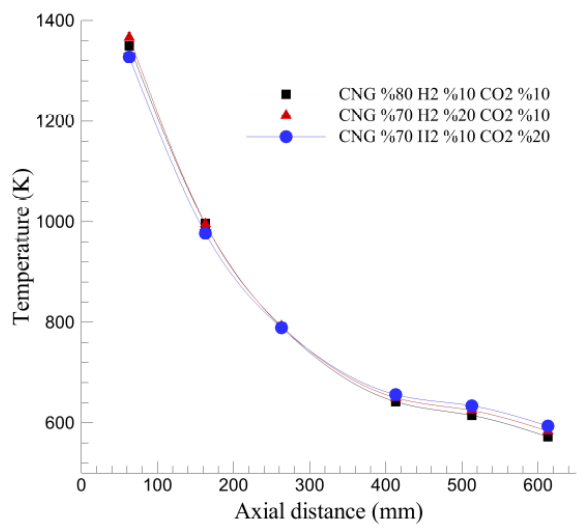
Figure 6: Axial temperature distributions (Swirl number: 0.4, Equiv- alence ratio: